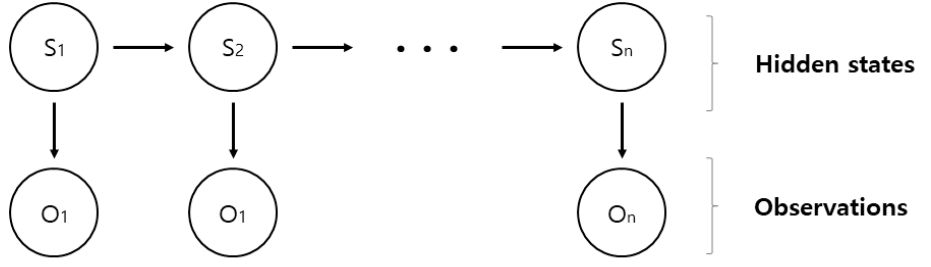
Figure 1. Hidden Markov Model Trellis Diagram. Figure 1 . Hidden Markov Model Trellis Diagram. Figure 1 . Hidden Markov Model Trellis Diagram.